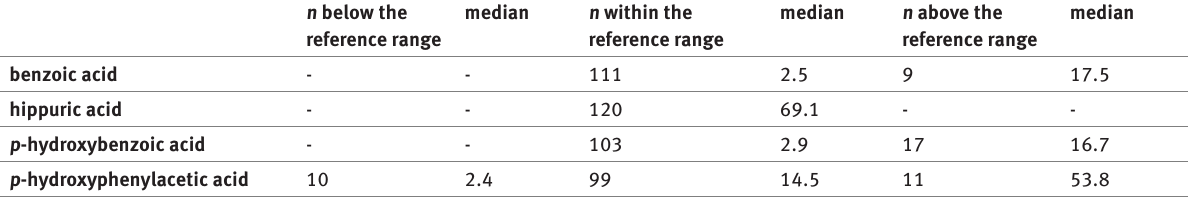
Table 2 Number of patients and median for values below, within and above the reference range